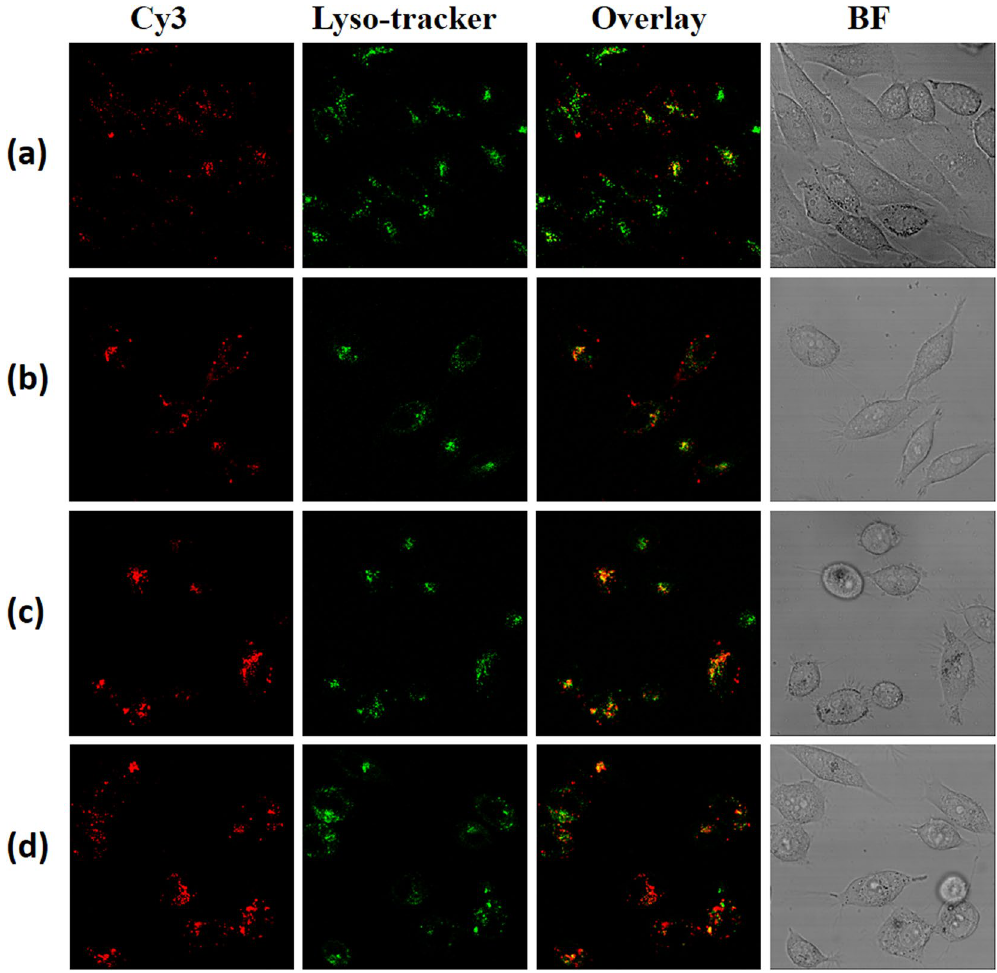
Figure 7. CLSM images of cells exposed to ( a ) PEI/Cy3-DNA, ( b ) MPEI/Cy3-DNA and MPEI@AuNS@NPEG/ Cy3-DNA ( c ) without or ( d ) with light irradiation. The endosome were dyed green by LysoTracker ® Green